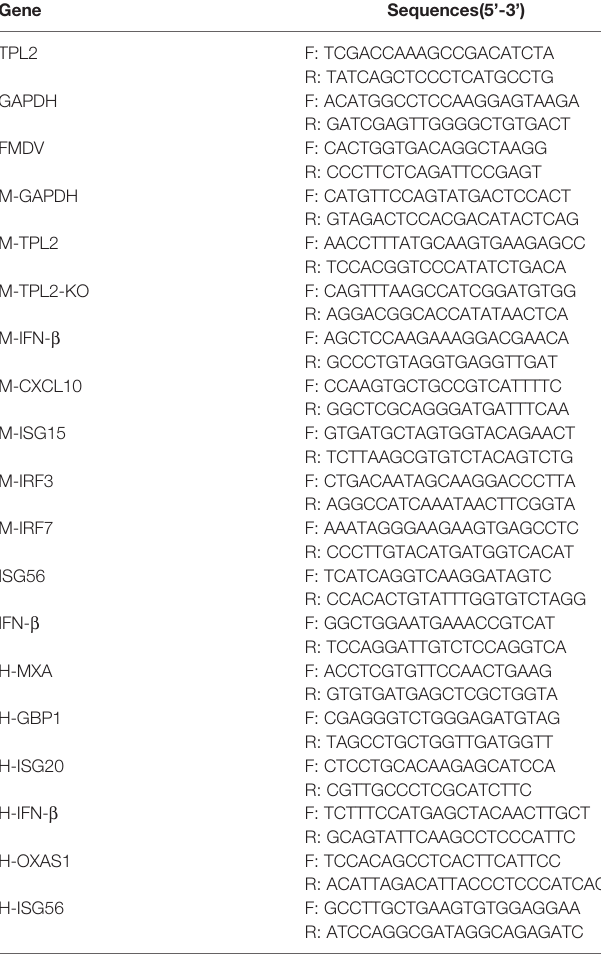
TABLE 1 | Primers used in this